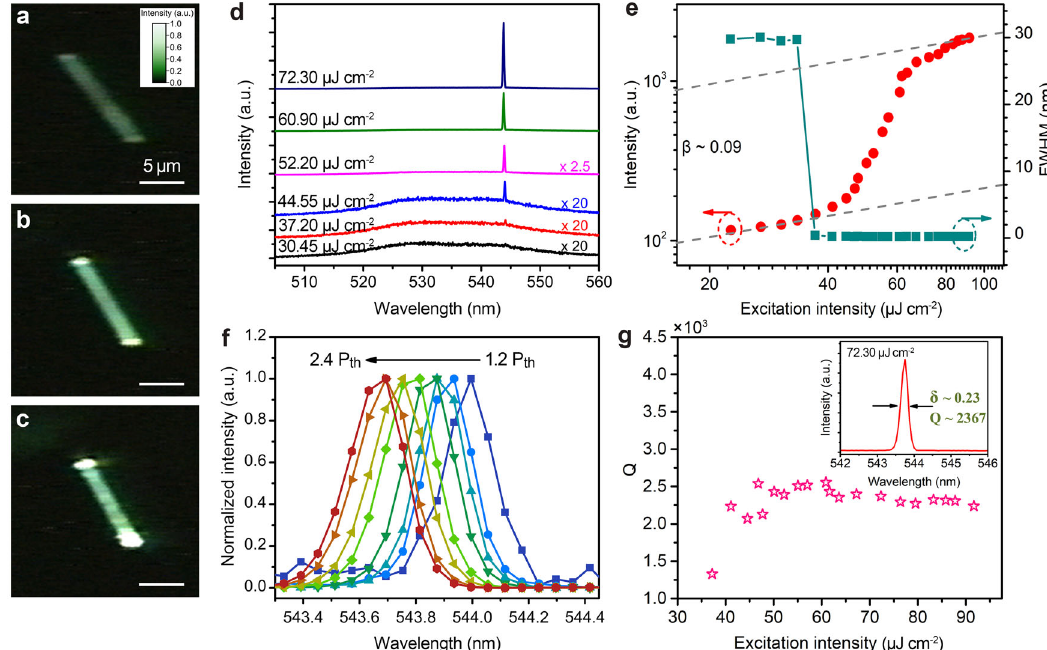
Fig. 2 Lasing characteristics of individual CsPbBr 3 microwire. Optical images of luminescence signal below threshold ( a ), at threshold ( b ) and above threshold ( c ) under 400-nm fs excitation. Scale bars in a – c are 5 μ m. d Emission spectra of CsPbBr 3 microwires at different pump fl uences. For clarity, the curves have been vertically shifted and some of them are magni fi ed. e Integrated emission intensity (red circles) and full width at half maximum (FWHM, cyan squares) versus excitation energy density. The error bars that represent the standard deviation from the mean are too small to be visible. The representative kink behavior is exhibited and the lasing threshold is derived to be about 37.2 μ J cm − 2 . The spontaneous emission coupling factor β is estimated to be ~0.09 from the “ S-shaped ” curve. f Enlarged spectra with various excitation energy from 1.2 to 2.4 P th . g The Q factors at various excitation fl uences above the lasing threshold. The error bars here are too small to be visible. Inset is the lasing spectrum at a pump fl uence of 72.3 μ J cm − 2 with a emission peak at 543.8 nm and a FWHM ( δλ ) of about 0.23 nm, corresponding to a Q factor of